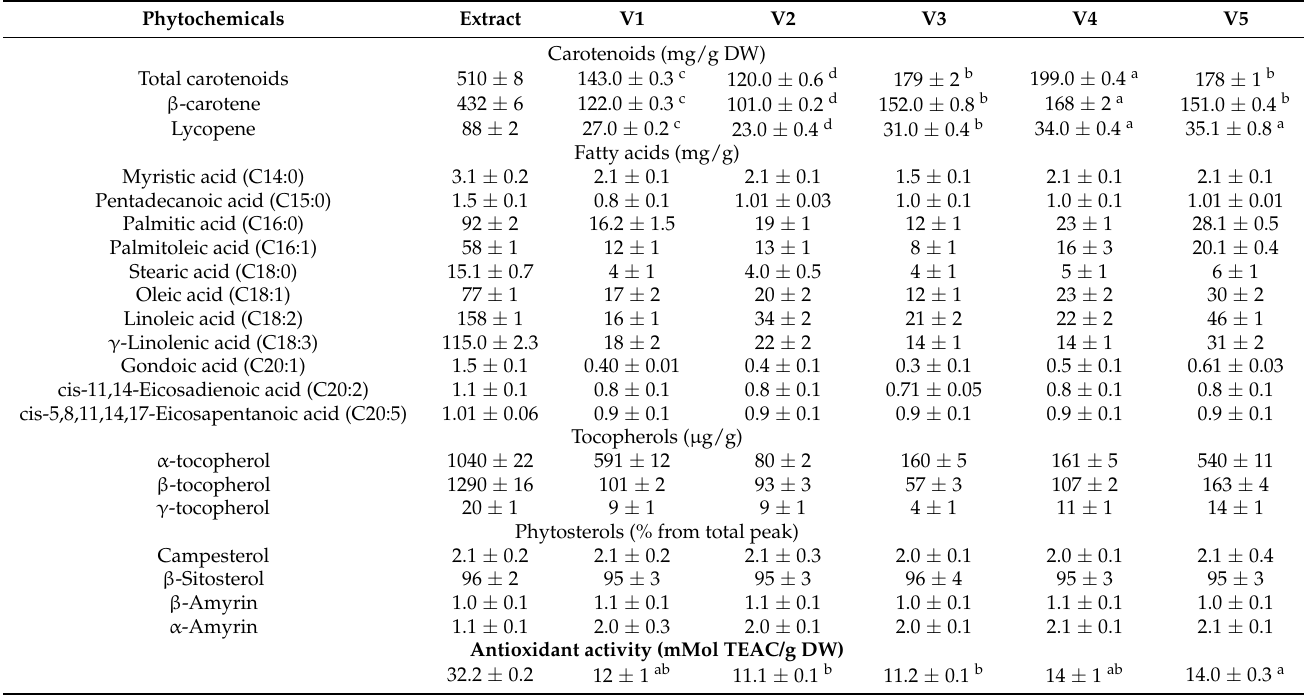
For carotenoids content, means that for the same row do not share the same superscript letter (a, b, c, d), are statistically different at p < 0.001 based on ANOVA and Tukey method. For antioxidant activity, means that do not share the same superscript letter (a, b) are significant at p < 0.001 based on ANOVA and Games–Howell method and 95%